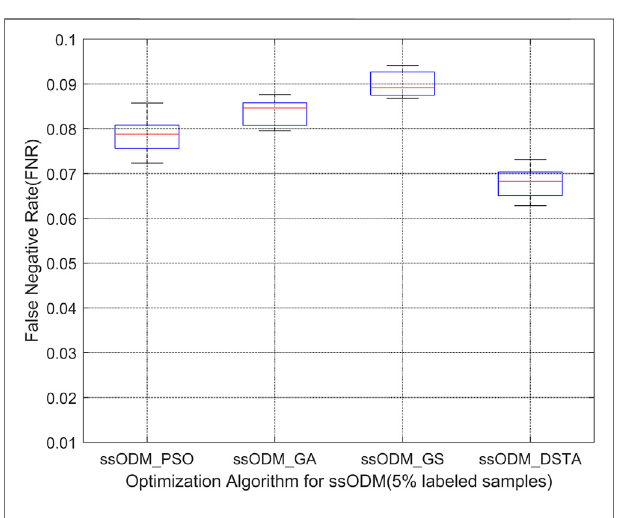
FIGURE 12 | Boxplot of FNR of low-temperature fault detection regarding the blade 2 axle box of the pitch (5% labeled samples).